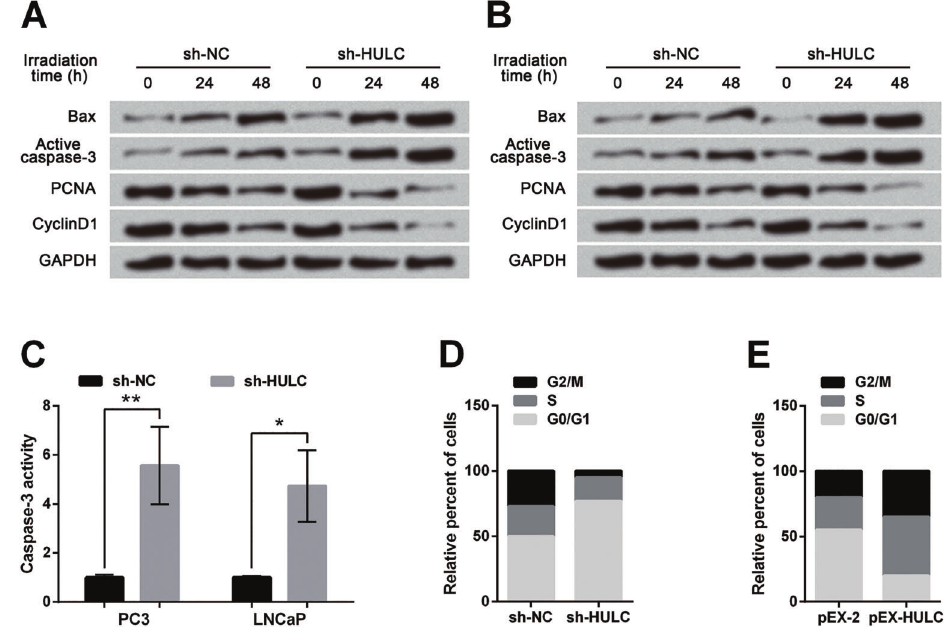
Figure 2. Effects of irradiation on prostate cancer cells were enhanced by HULC knockdown. A dose of 6 Gy irradiation was delivered to cells. Expressions of cell cycle-associated proteins were down-regulated while expressions of apoptosis-associated proteins were up-regulated by HULC knockdown in PC3 cells ( A ) and LNCaP cells ( B ). C , Caspase-3 activity was enhanced by HULC knockdown. D , HULC silence arrested PC3 cells at G0/G1 phase. E , HULC overexpression arrested PC3 cells at S phase. Data are reported as means ± SD. *P o 0.05; **P o 0.01 ( t -test). HULC: long non-coding RNA highly upregulated in liver cancer; sh-HULC: pGPU6/GFP/Neo plasmid carrying short-hairpin RNA targeting HULC; sh-NC; pGPU6/GFP/Neo plasmid carrying a non-targeting RNA; pEX-HULC: pEX-2 plasmid carrying full-length HULC; PCNA: proliferating cell nuclear antigen.